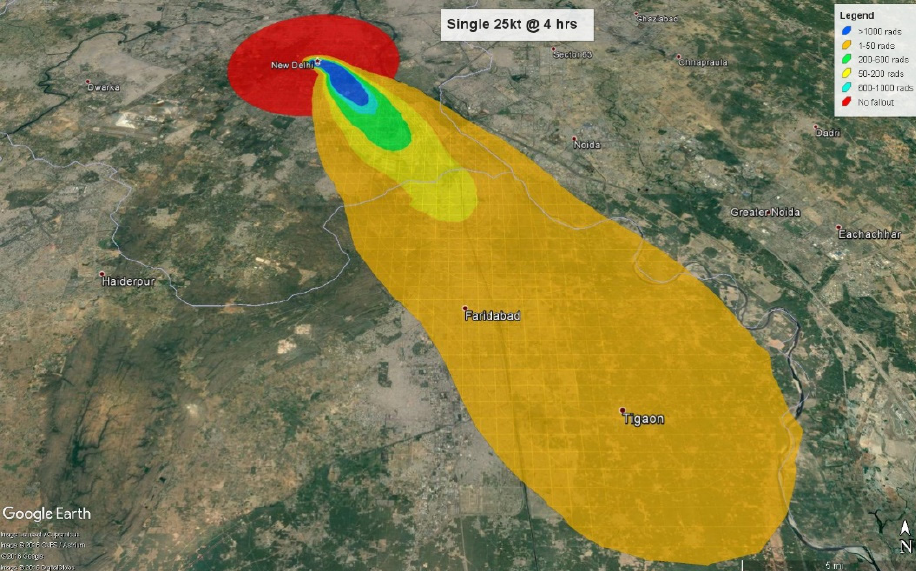
Figure 5. Combined injuries by triage categories.